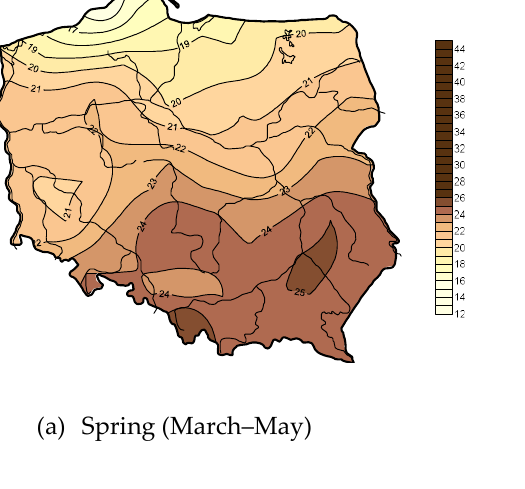
(a) Spring (March–May) (b) Summer (June–August)